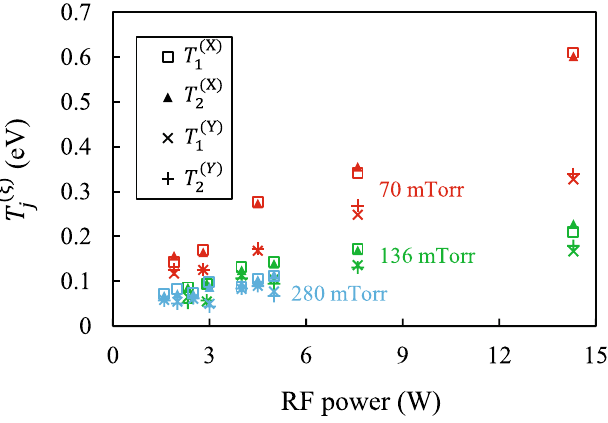
( ξ ) Figure 4. Effective temperatures T j of the stochastic processes driving the microparticles, depending on the RF power at different gas pressures.